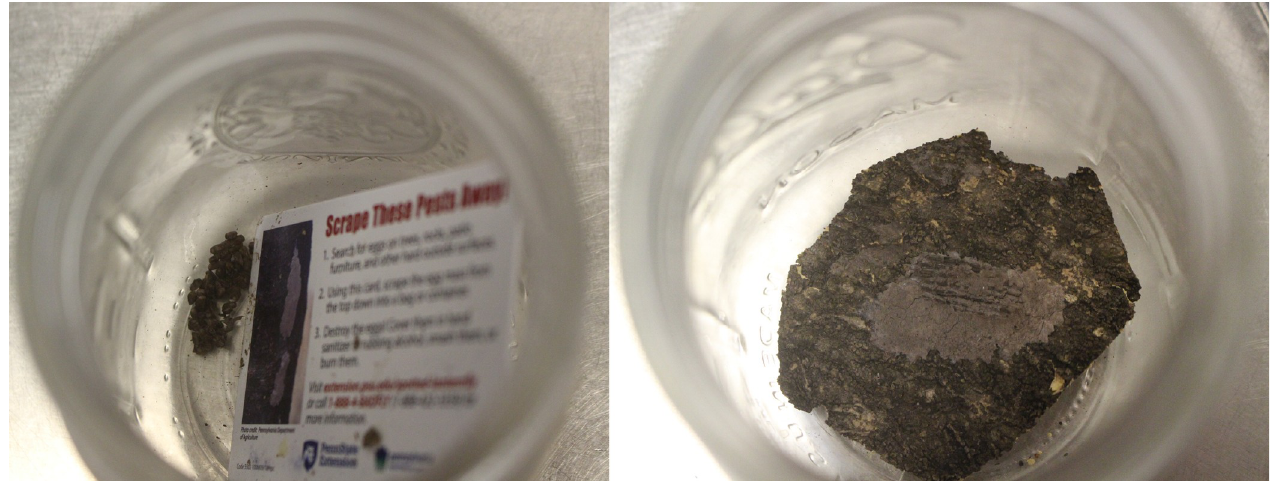
Fig 4. Pictures of the training target odor of dead spotted lanternfly egg masses–scraped eggs off bark (A) and eggs on bark (B).